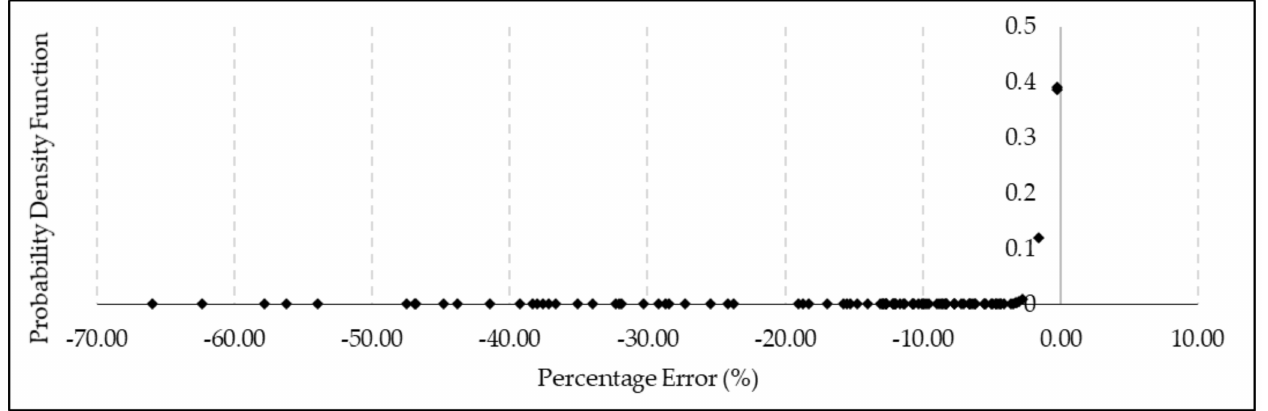
Figure 12. Probability density function of normalized failure pressure predictions using DNV method when compared to FEM for API 5L X80 pipe subjected to internal pressure and axial compressive